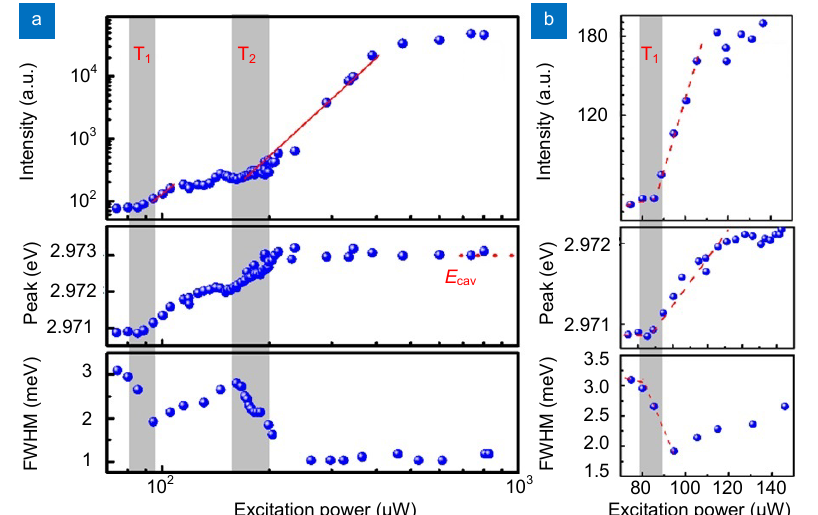
Fig. 3 | ( a ) The dependence of luminous intensity, peak position and half-width of LPB on the excitation power with double nonlinear regimes. ( b ) Enlarged polariton lasing region with linear coordinates. (T 1 and T 2 denote the polariton lasing threshold and photonic lasing threshold)